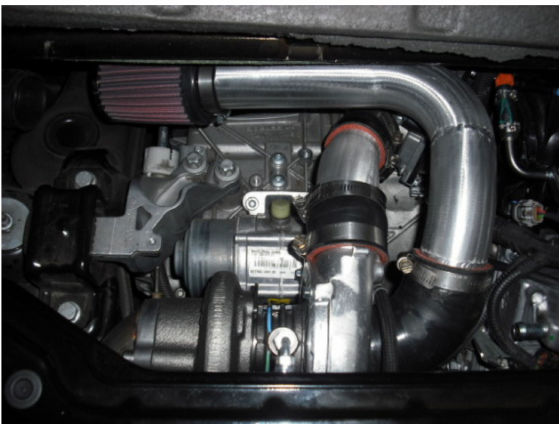
Figure 6. The turbocharged W451, 998 cc, 62 kW engine.